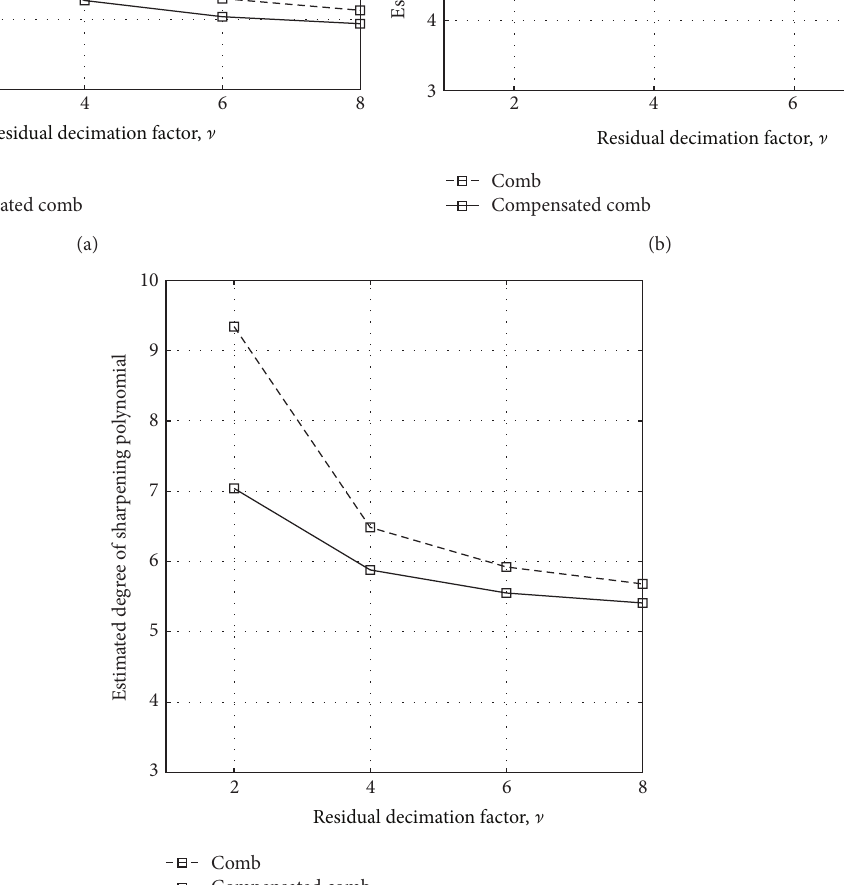
the range of frequencies Ω 𝑝 = [0, 𝜔 𝑝 ] into 𝑚 equally spaced points ̃𝜔 𝑖,𝑝 and the range of frequencies Ω 1 = , (2𝜋/𝑀) + 𝜔 ] into 𝑚 equally spaced [(2𝜋/𝑀) − 𝜔 𝑝 𝑝 points ̃𝜔 𝑖,𝑠 , with 𝑖 = 1, 2, . . . , 𝑚 . Then, we set ̃𝑥 𝑖,𝑝 = 𝐹( ̃ 𝜔 ) and ̃ 𝑥 = 𝐹( ̃ 𝜔 ) . 𝑖,𝑝 𝑖,𝑠 𝑖,𝑠